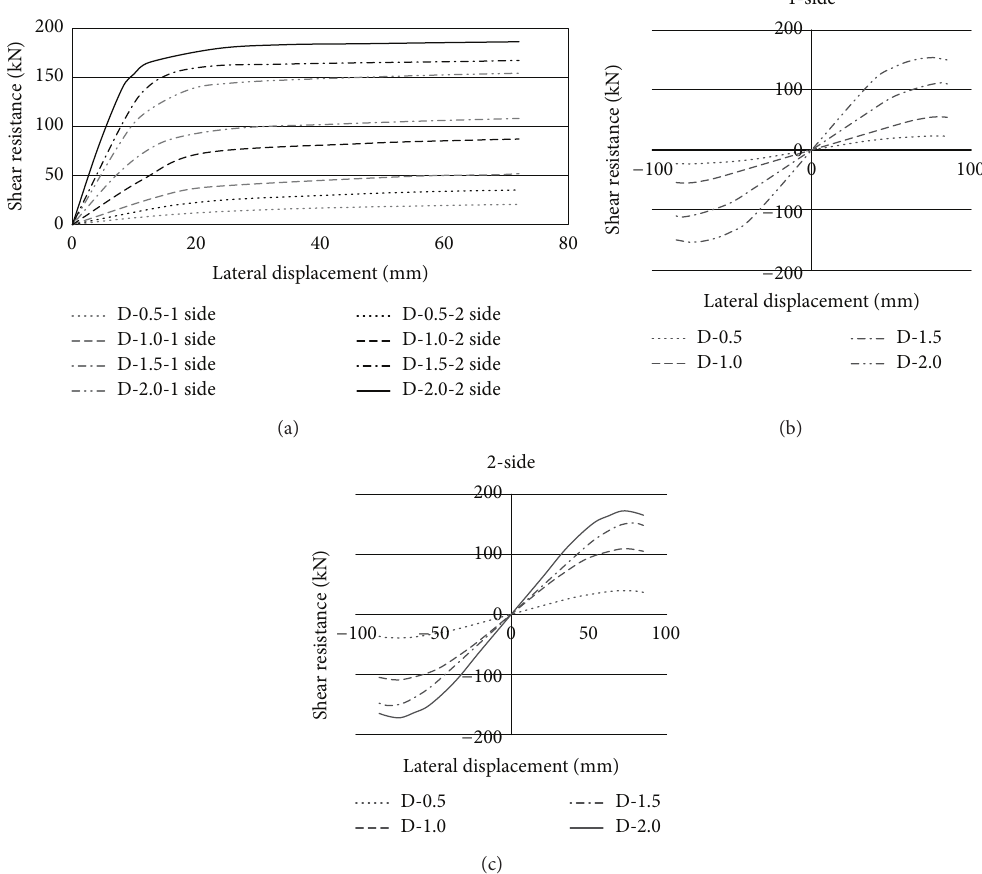
Figure 6: Curves of specimens D. (a) Monotonic curves. (b) Hysteretic envelope curves 1-side. (c) Hysteretic envelope curves